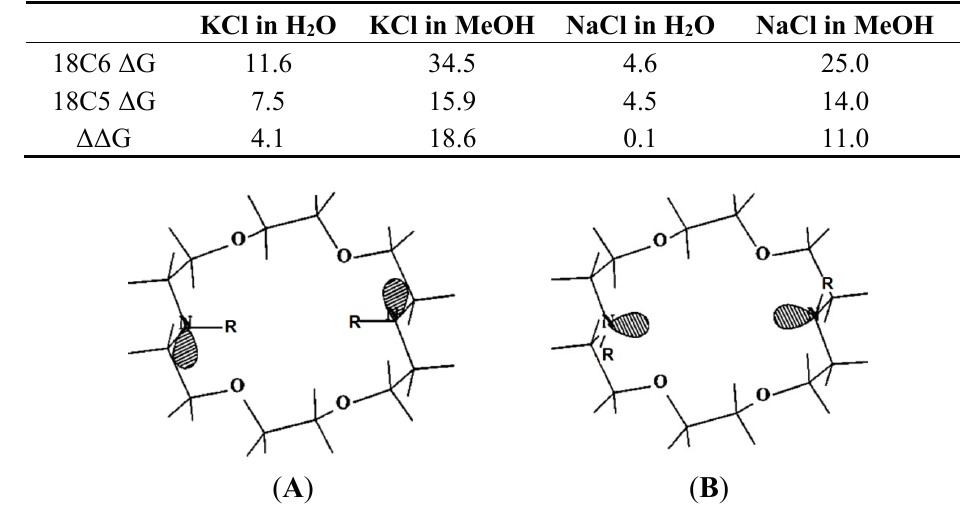
Table 1. Complexation free energies (in kJ/mol) of crown ethers in different solvents, with differences between 18C6 and 18C5.